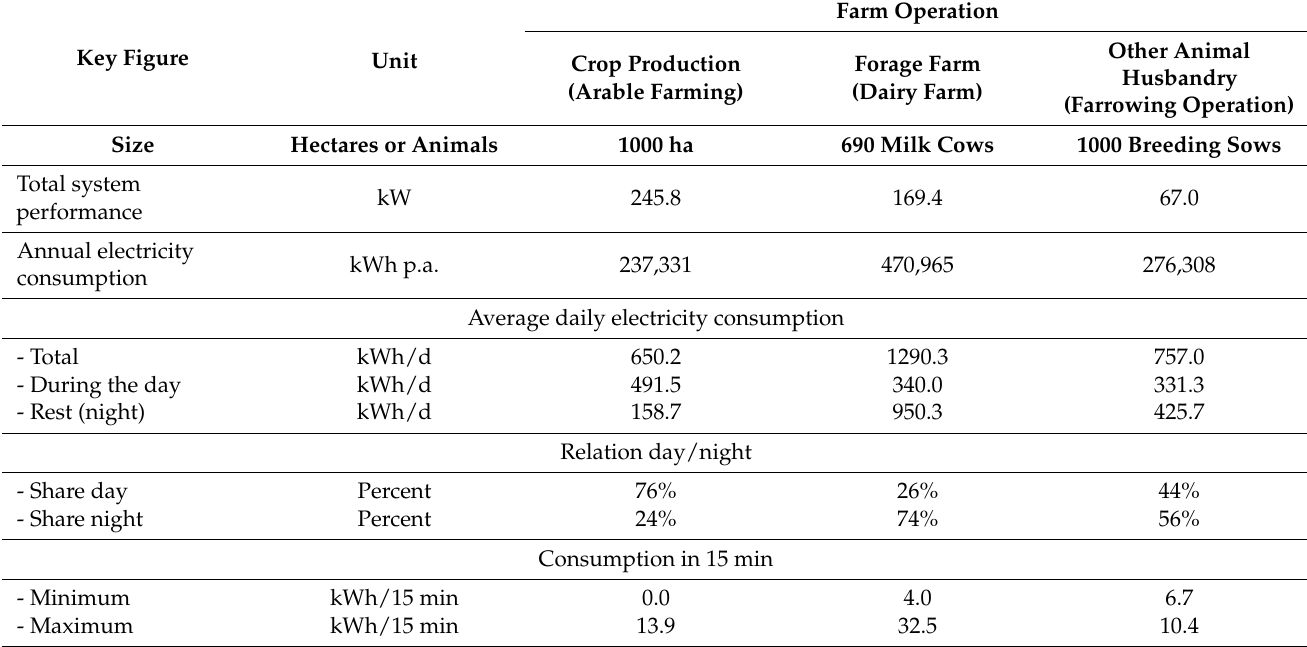
Table 4. Typical average daily electricity consumption of various farm operations: regular electricity consumption without variable additional power consumption for forage farm (dairy farm) and other animal husbandry (farrowing operation, piglet rearing, pig fattening, broiler